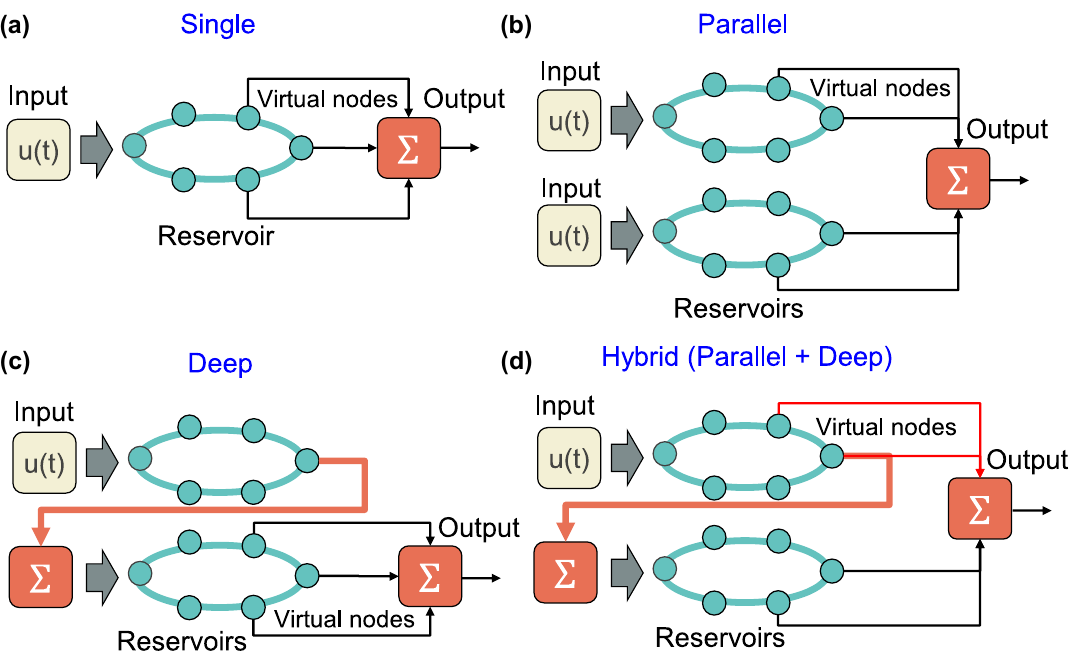
Figure 2: Configurations of parallel and deep reservoir computing. (a) Single reservoir, (b) parallel reservoirs, (c) deep reservoirs, and (d) hybrid